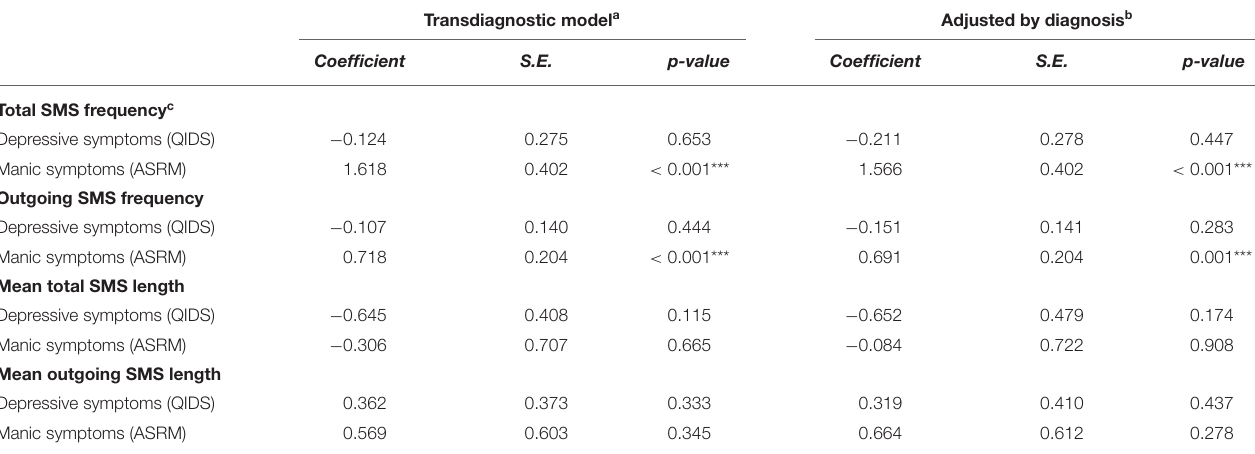
TABLE 3 | SMS data by mood